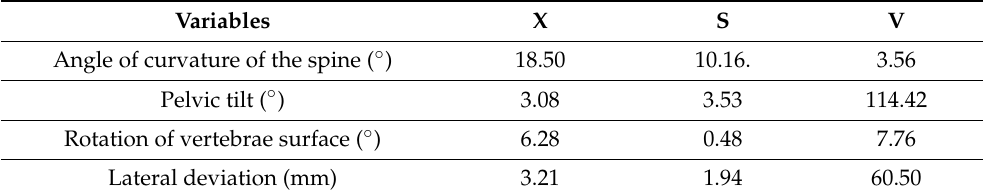
Table 1. Variables of tested parameters (x: arithmetic average; s: standard deviation; V: coefficient of variation).